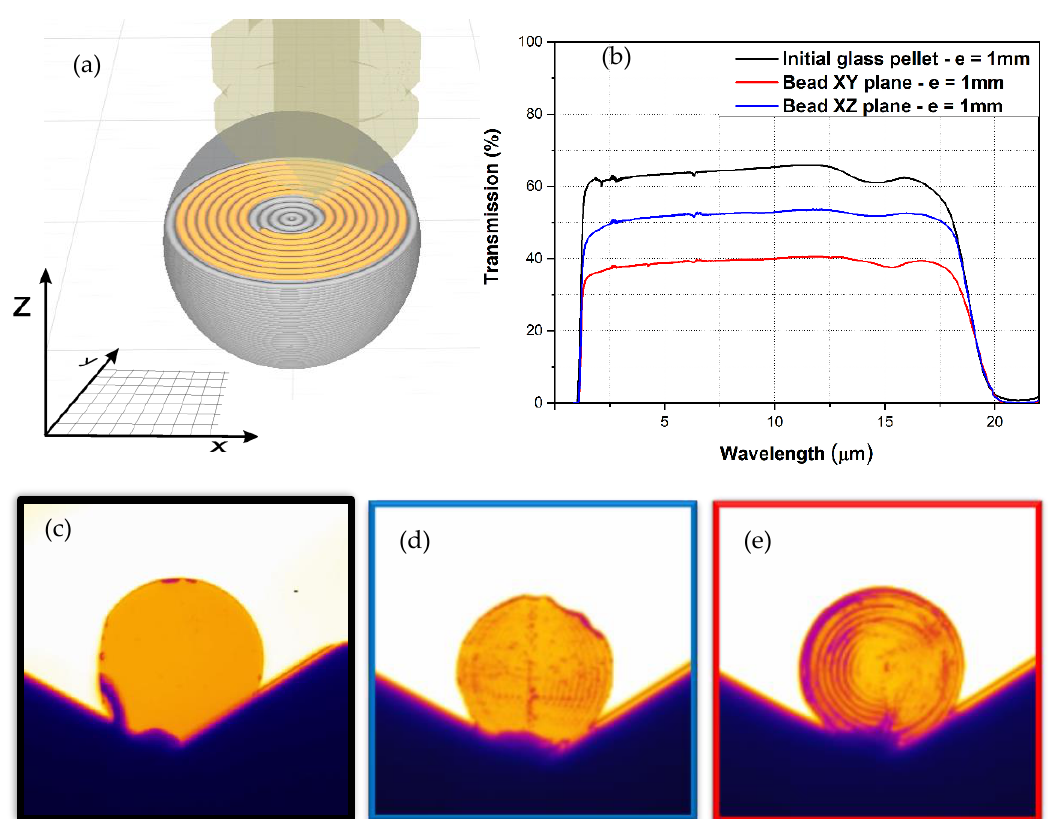
Crystals 2021 , 11 , x FOR PEER REVIEW Figure 5. Optical transmission of printed beads: ( a ) numerical view of the 3D printing process, ( b ) initial glass transmission compared to the transmission of 2 disks cut in the XY plan (red curve) and XZ plan (blue curve), respectively. IR camera views in the 7-13 µm window ( c ) initial TAS glass, ( d ) XZ plan, ( e ) XY plan.